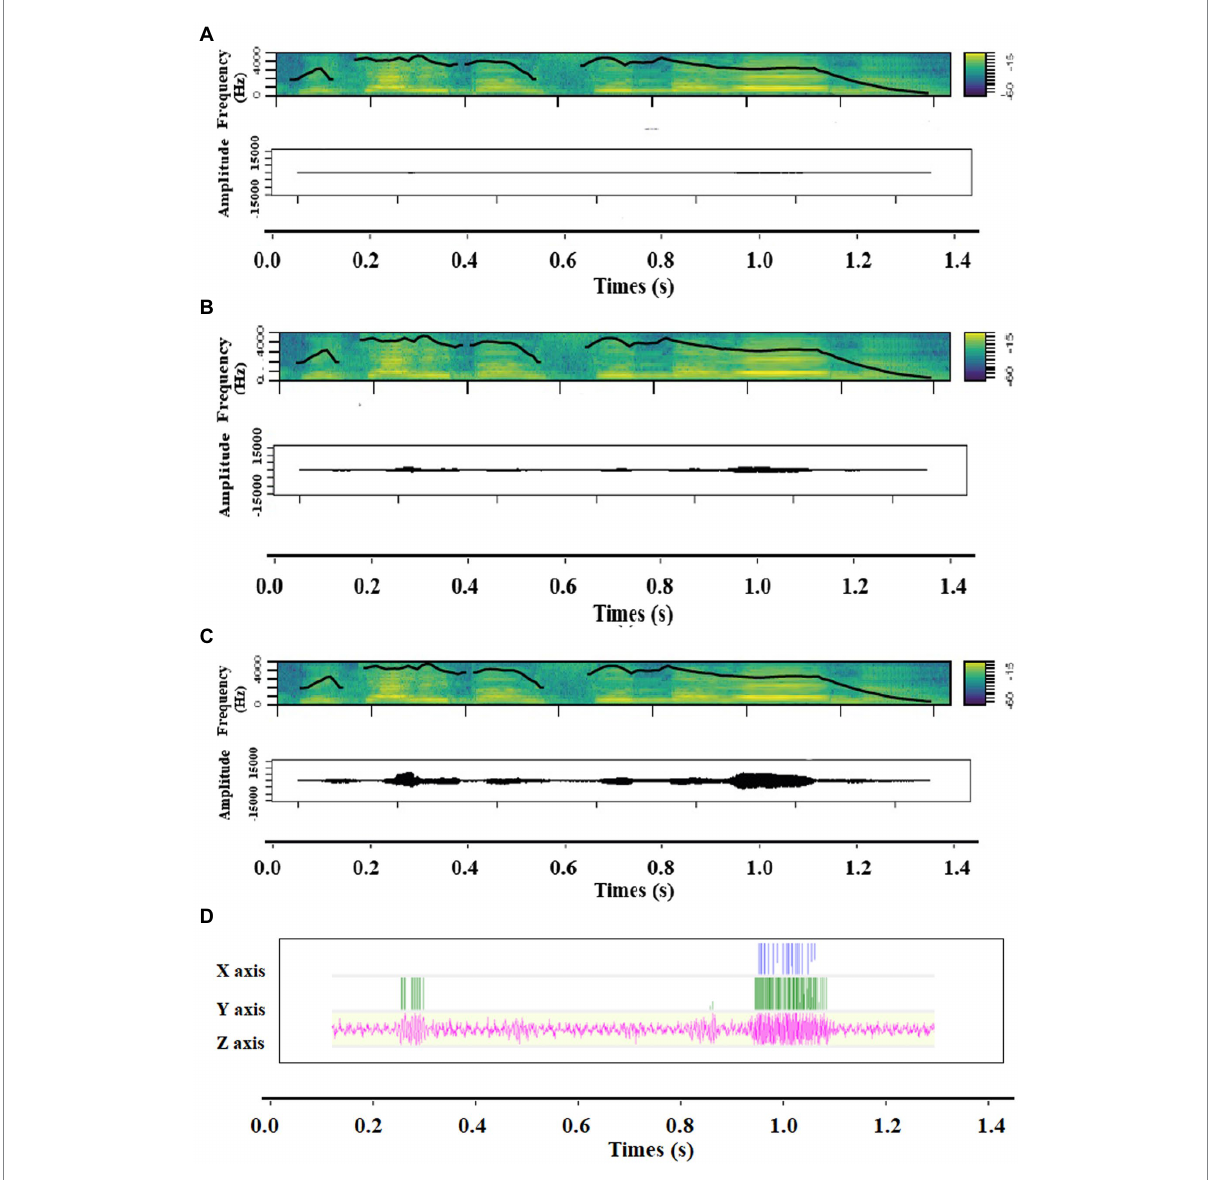
FIGURE 1 Spectrograms including contour of fundamental frequency and Amplitude time series of (A) Low intensity, (B) Medium intensity and (C) High intensity, as well as (D) the accelerometer signal of the vibration of a sound expressing